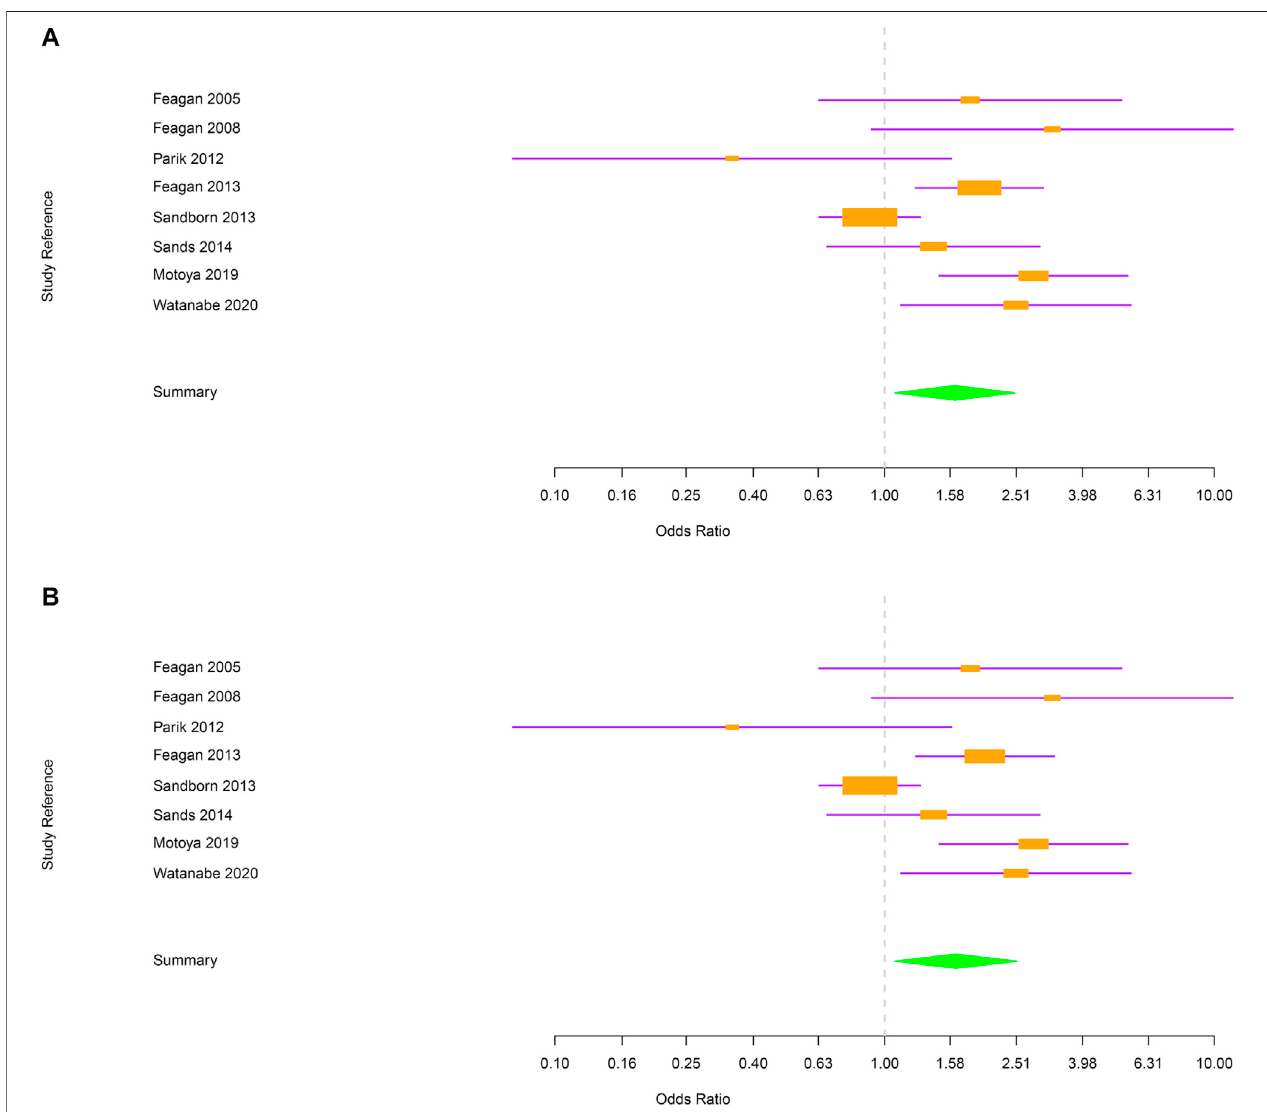
FIGURE 2 | (A) Forest plot for the rate of respiratory tract infections in in fl ammatory bowel disease patients. (B) Forest plot for the rate of upper respiratory tract infections in in fl ammatory bowel disease patients.